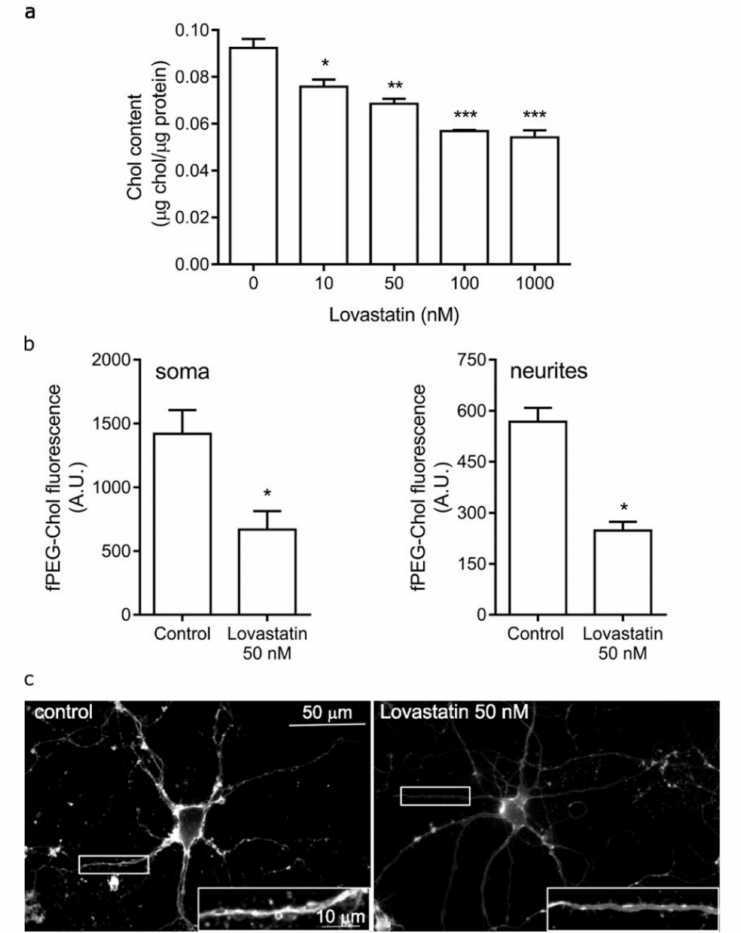
Figure 1. Lovastatin treatment reduced total and surface cholesterol levels in cultured hippocampal neurons. ( a ) Cultured hippocampal neurons were treated with di ff erent lovastatin concentrations for 14 days and, at the end of the incubation, total cholesterol levels were measured. ( b ) Cultured hippocampal neurons were treated with 50 nM lovastatin for 14 days or left untreated (control). At the end of the incubation, surface cholesterol was identified with the fluorescent analogue fluorescein ester of polyethylene glycol-derivatized cholesterol (fPEG-Chol). Neuronal cells were imaged and fluorescence from the soma and neurites was quantified. ( c ) Neurons treated as in ( b ) showing the di ff erent regions analyzed. Scale bar: 50 µ m, inset: 10 µ m. Data represent the mean ± SD of at least three independent experiments. * p < 0.01, ** p < 0.0025, *** p <